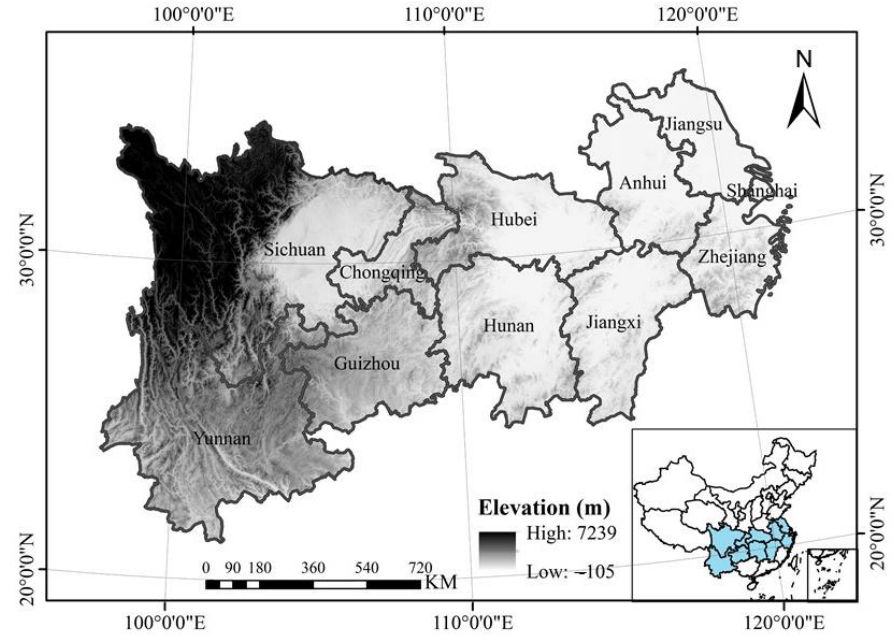
Figure 1. Geographical location of the Yangtze River Economic Belt.